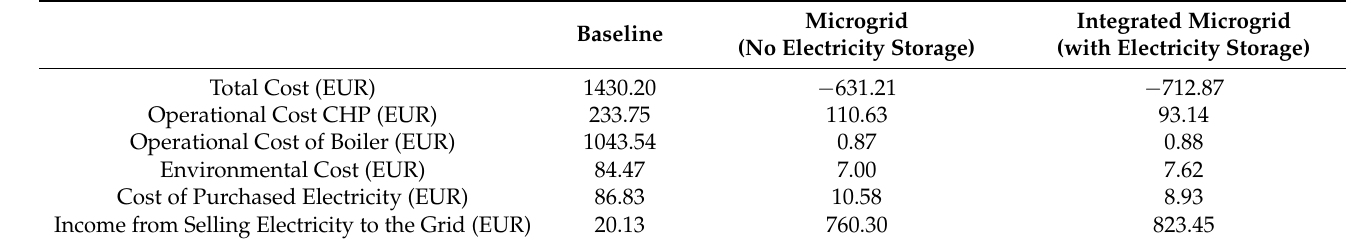
Table 7. Cost breakdown for the different scenarios considered.